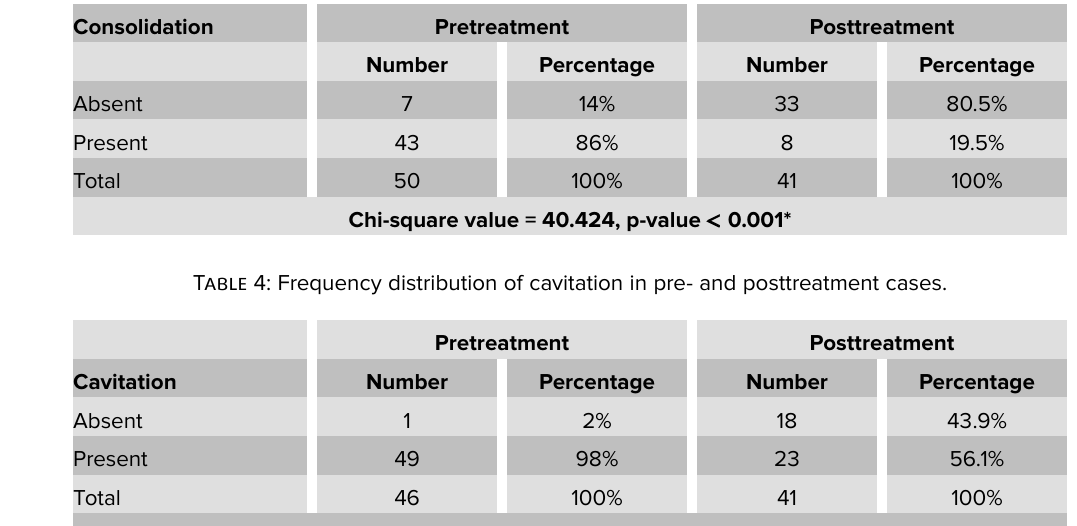
TABLE 3: Frequency distribution of consolidation in pre- and posttreatment cases.